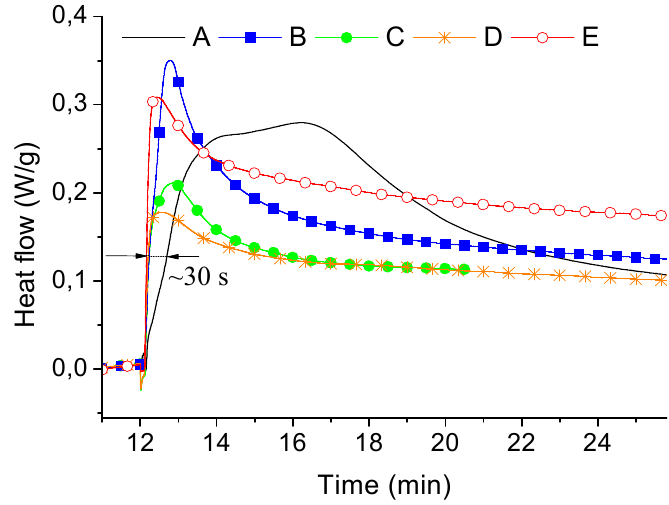
Figure 3. Oxidation induction time (isothermal OIT) for samples A, B, C, D, and E.